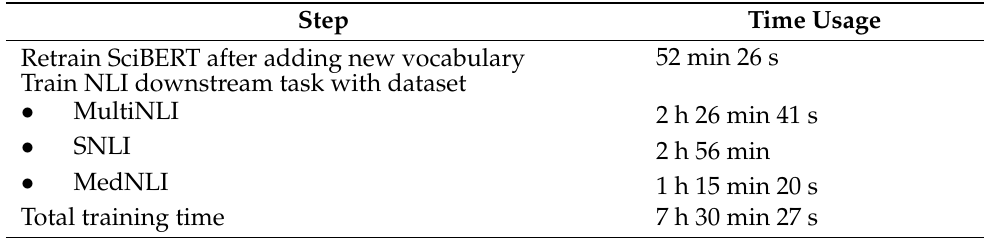
Table 8. Time usage in each step of the training zero-shot classification model.